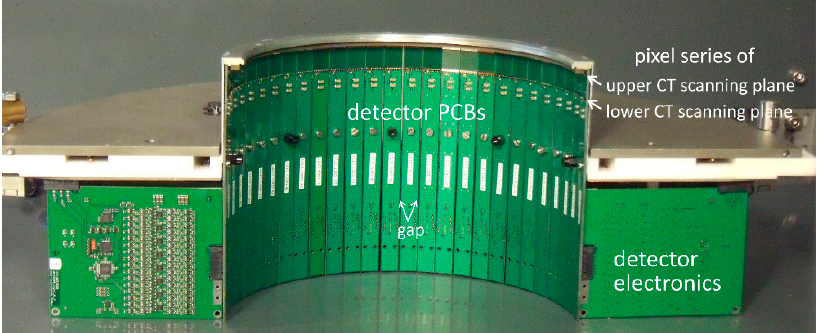
Figure 11. Photography of half of the latest UFXCT detector electronics.